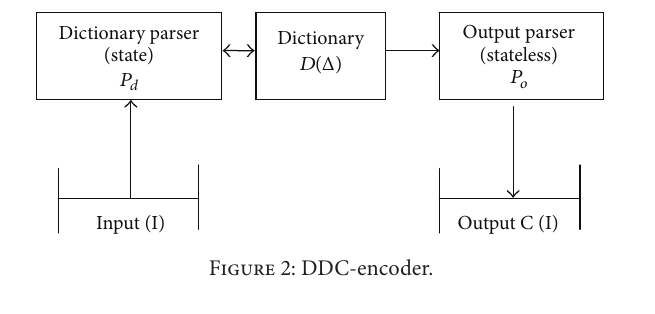
Figure 2: DDC-encoder.